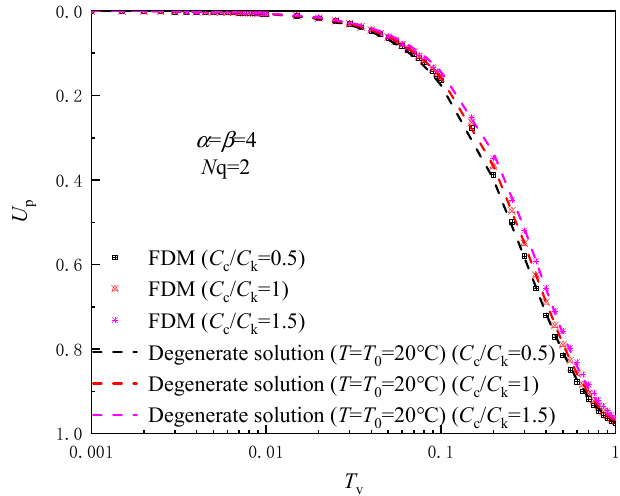
Figure 3. Comparisons between the finite difference solution and the present degradation.